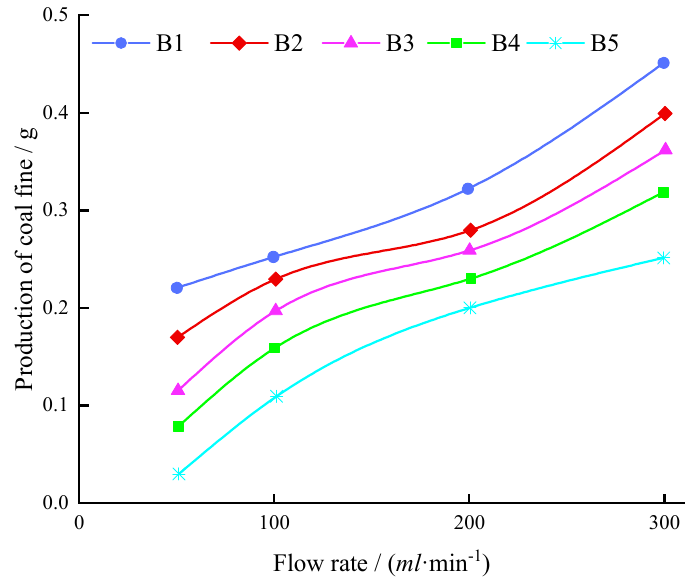
increased, which prevented the coal powder from adhering and depositing. However, some coal powder was still clogged in the proppant pore throat because of the hydrophobicity of pulverized coal. When the flow rate was the same, the output of pulverized coal after the addition of fiber significantly reduced, and the greater the amount of fiber added, the the lower the output of pulverized coal. lower the output of pulverized coal.